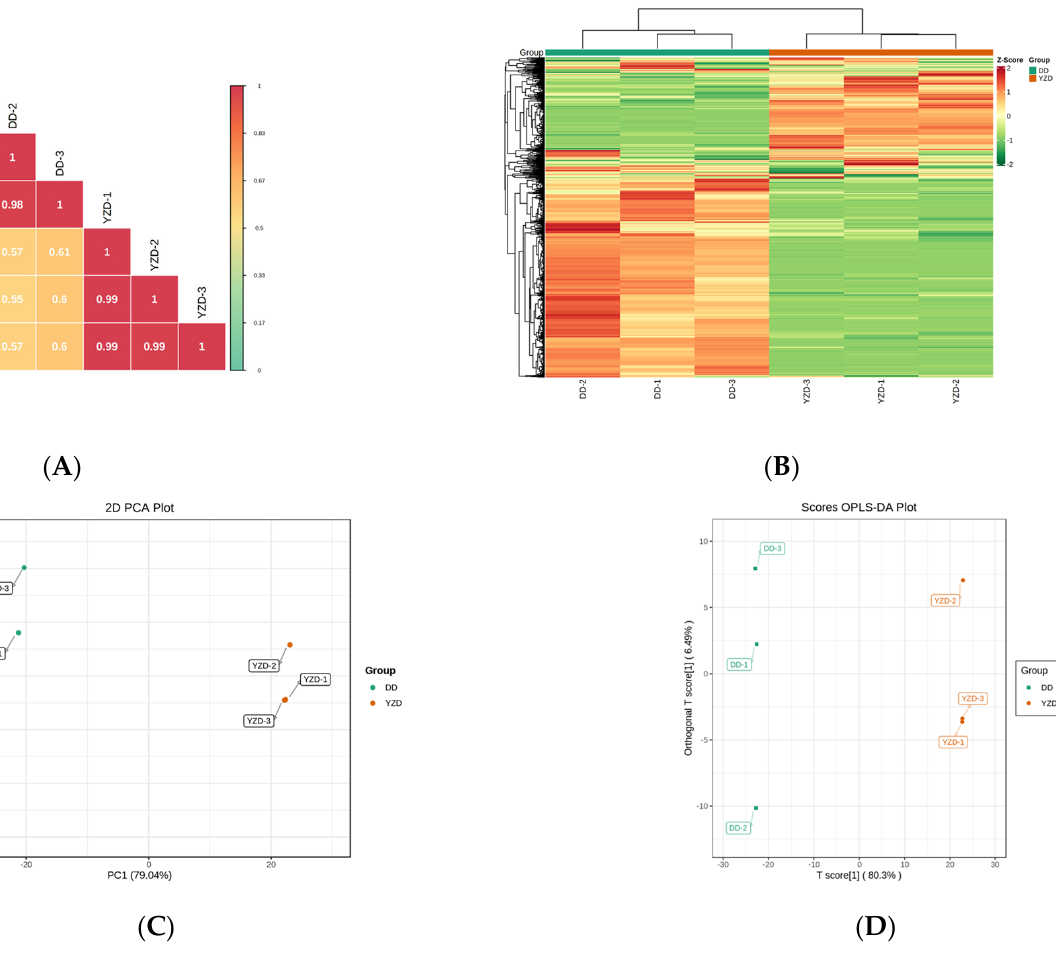
Figure 5. Multivariate analysis of identified metabolites. ( A ) Pearson’s correlation coefficients among the DD and YZD samples. ( B ) Hierarchical cluster analysis of the identified metabolites from the DD and YZD samples. ( C ) PCA of YZD and DD. ( D ) OPLS-DA of YZD and DD.